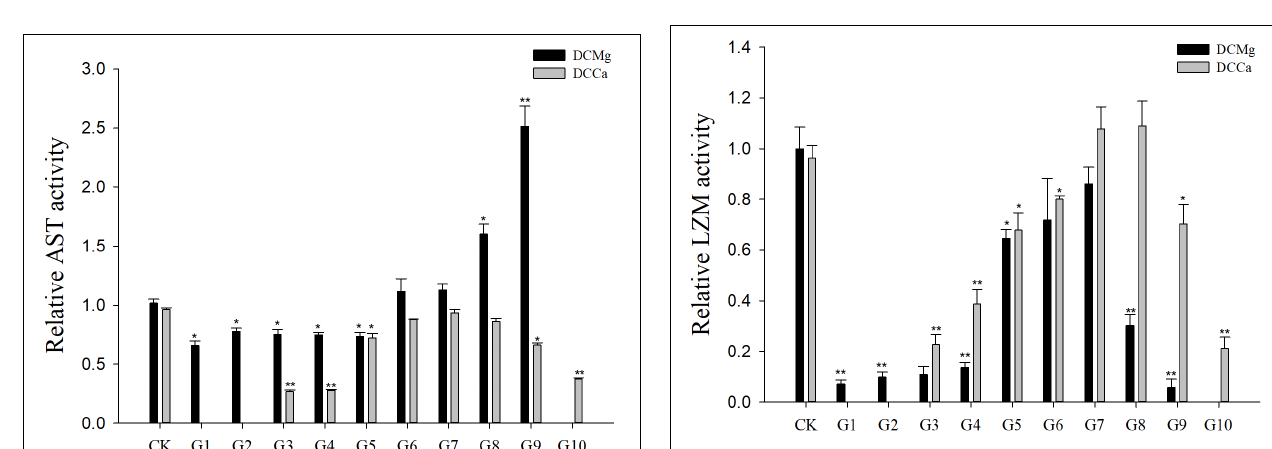
FIGURE 6 | Relative AST activity of JSCs under long-term stress with different Ca 2 + and Mg 2 + concentrations. Results show AST activity at 30-days normalized to the 0-day. Bars (mean ± SE, n = 3) with an asterisk denote a significant difference ( ∗ P < 0.05, ∗∗ P < 0.001) between the test groups (G1–G10) and CK.